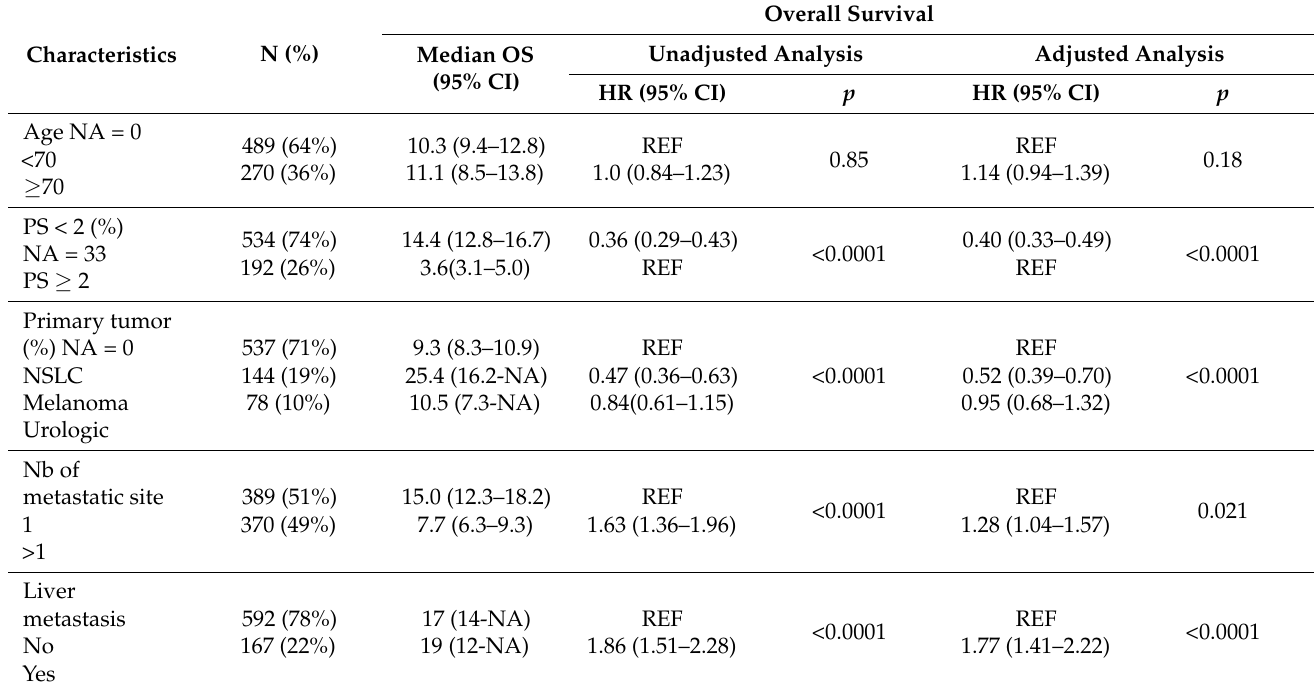
Table 2. Overall survival prognostic factors in univariate and multivariate analysis (Cox